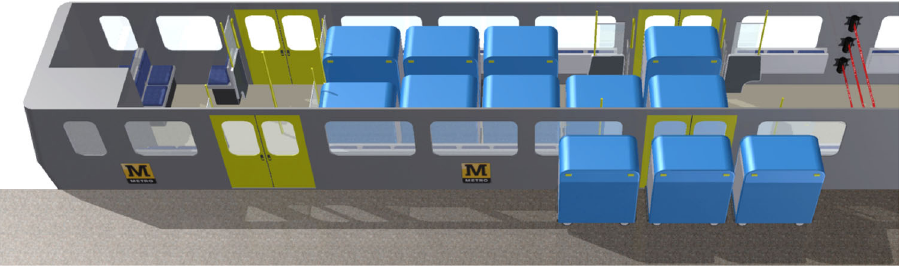
Fig. 22 Metro AGVs in full operation